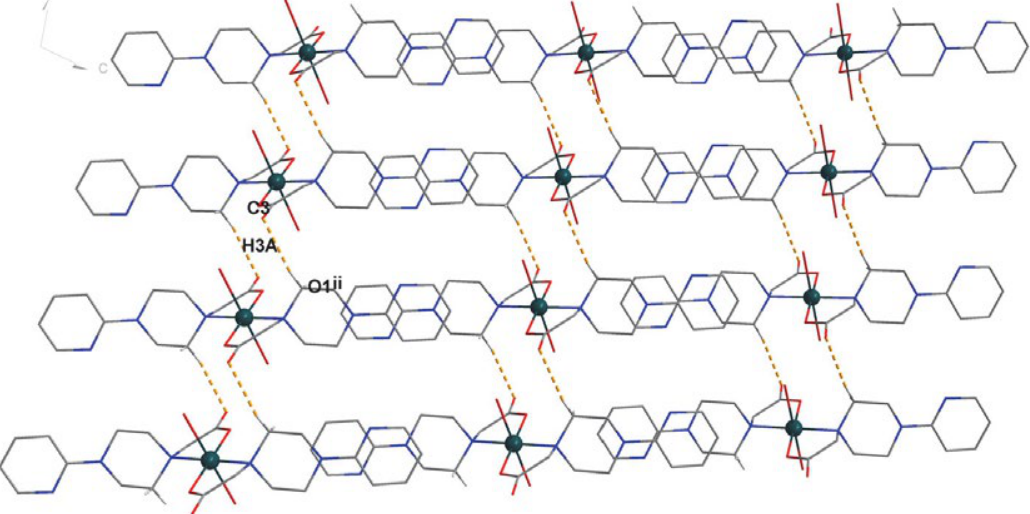
Figure 3. The hydrogen-bond-driven 2D sheet of 1 extended in bc plane. Symmetry code: (ii) 1 + x, y,